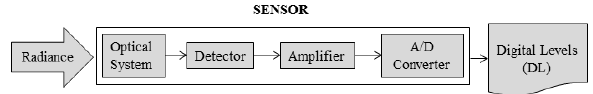
Figure 1 outlines the operation of all these devices. Detectors